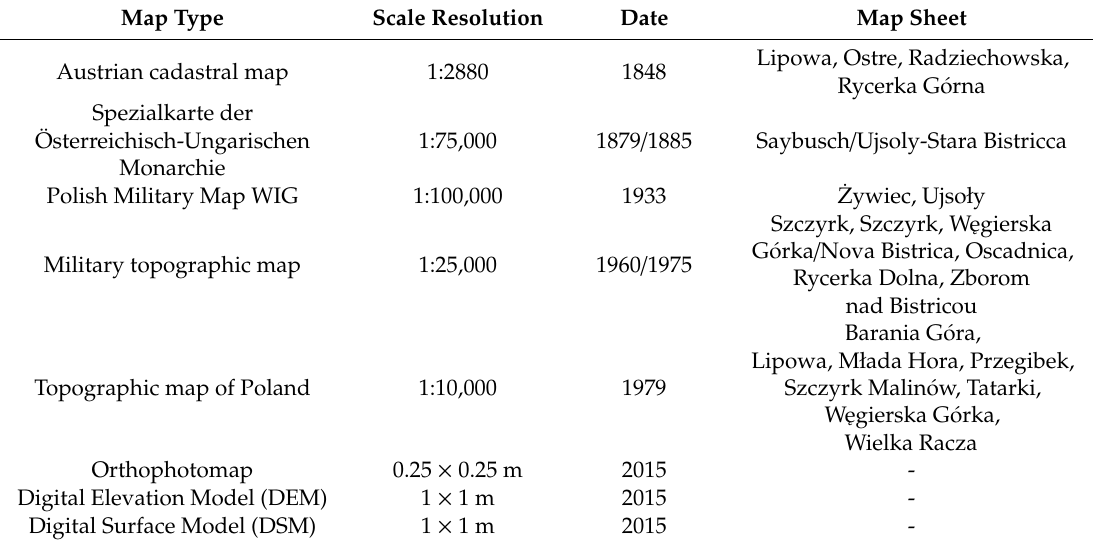
Table 2. Cartographic materials used for the